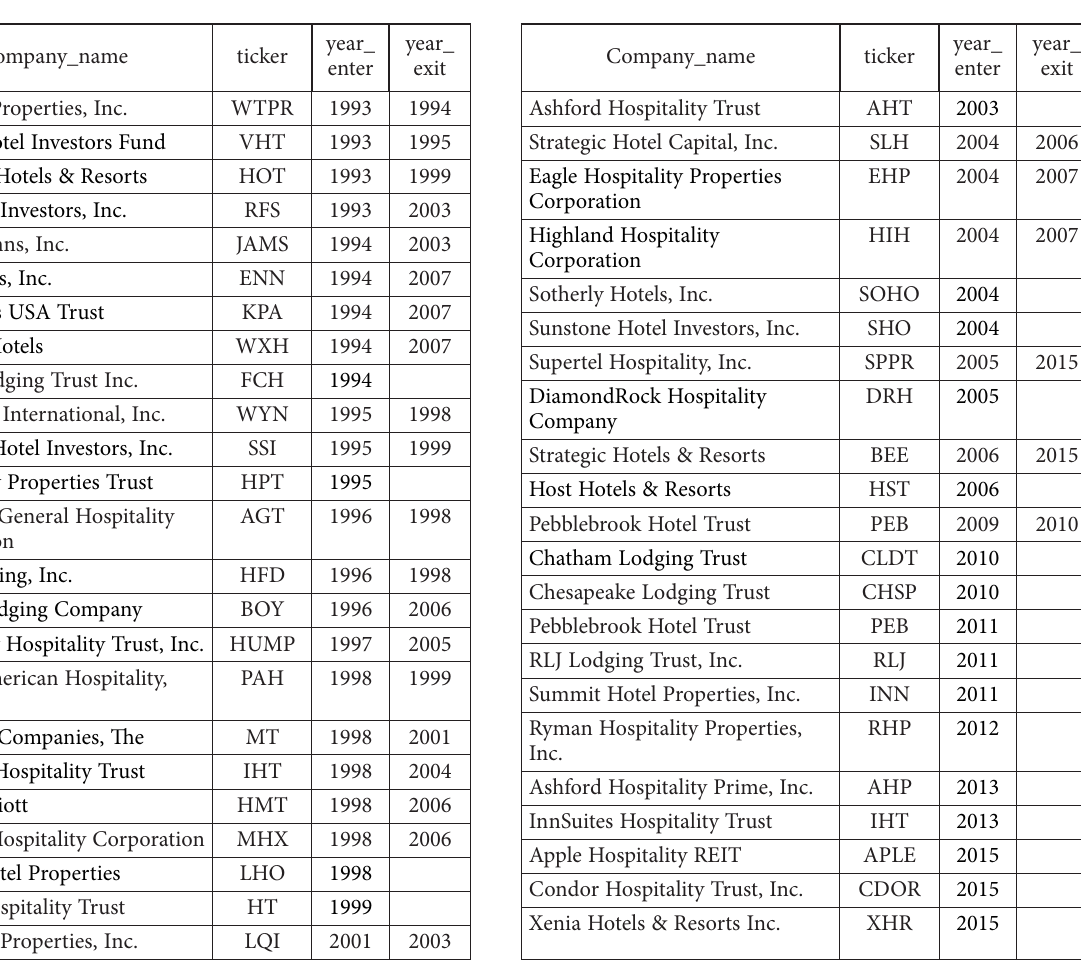
Table A1. Constituent companies of the FTSE NAREIT Lodging/Resort REITs Subsector Index (source: Feng et al. (2011) updated. http://www.mckayprice.com/ERE-